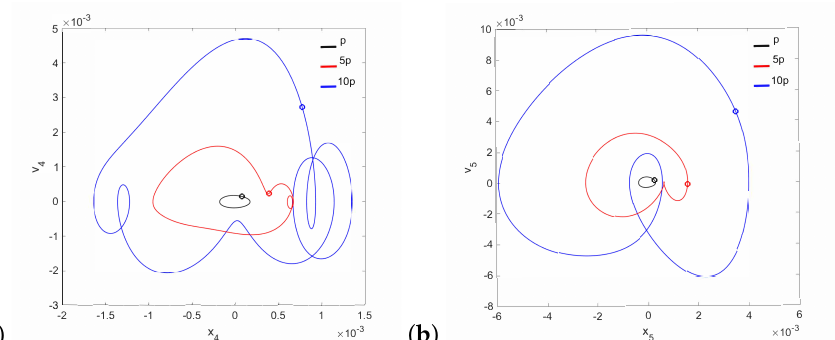
Figure 6. Phase diagrams of FMT motion near the first resonance in the normal ear for γ 24 = 2 × 10 6 : the can ( a ) and the magnet ( b ).